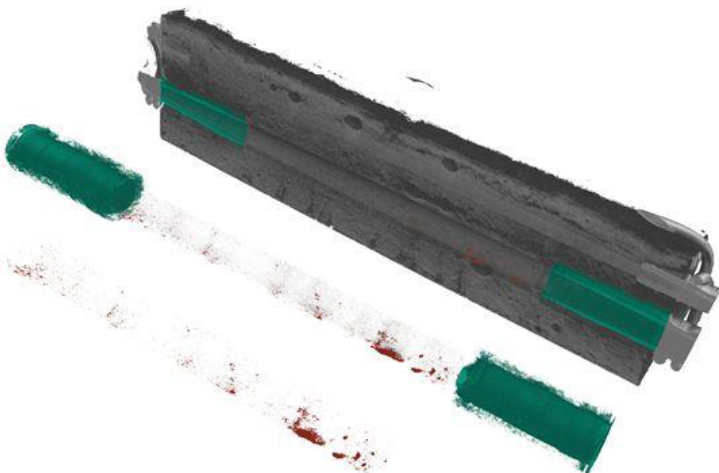
Figure 11. 3D visualization of corrosion products around rebar in reinforced concrete (image from a test run at PSI, partly published in [24]). The diameter of the steel rebar in the core of the speci- men is 8 mm.